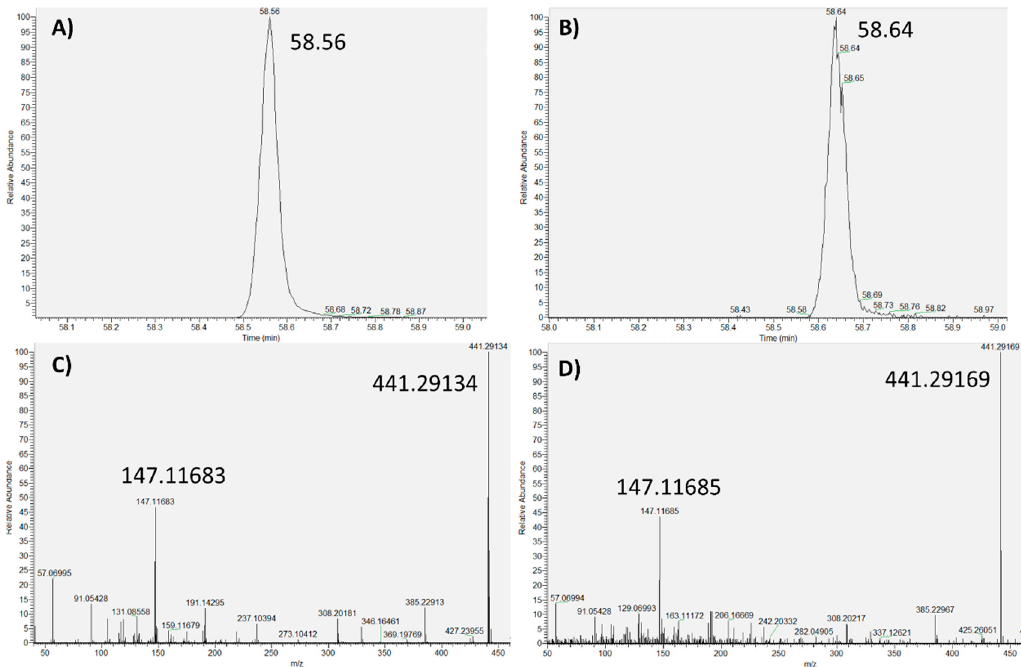
Figure 3. Tris (2,4-di-tert-butylphenyl) phosphite (Irgafos 168): ( A ) Base peak (standard); ( B ) Base peak (sample); ( C ) MS spectrum (standard); ( D ) MS spectrum (sample).